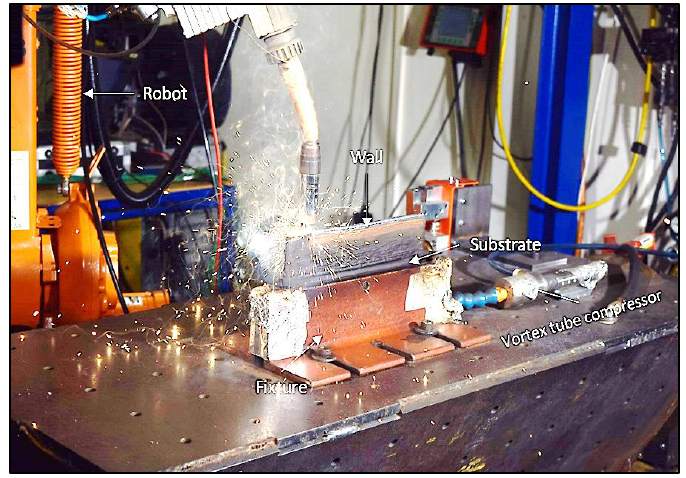
Figure 4. Setup for the WAAM.